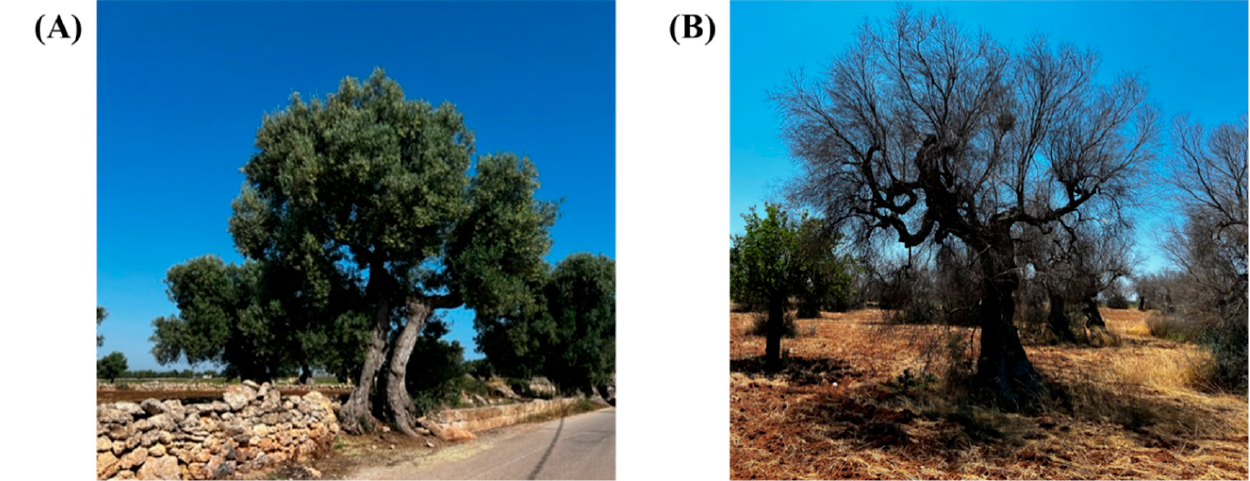
Figure 2. Olive trees undamaged ( A ) and severely damaged ( B ) by Xfp in the Apulia region.